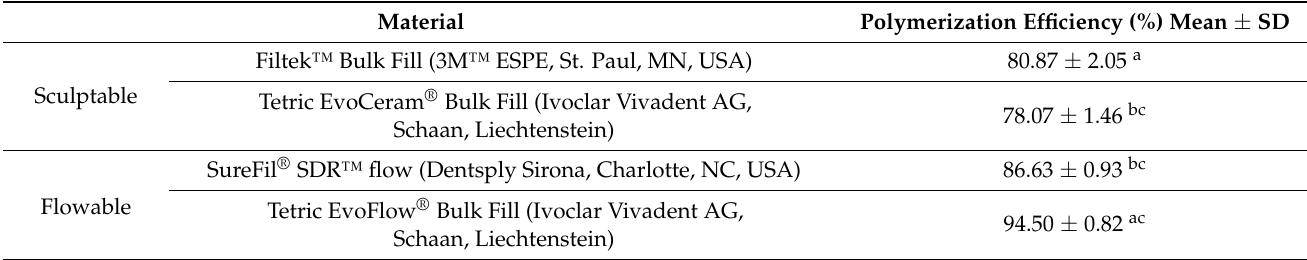
Table 2. Efficiency of polymerization (derived from the FTIR